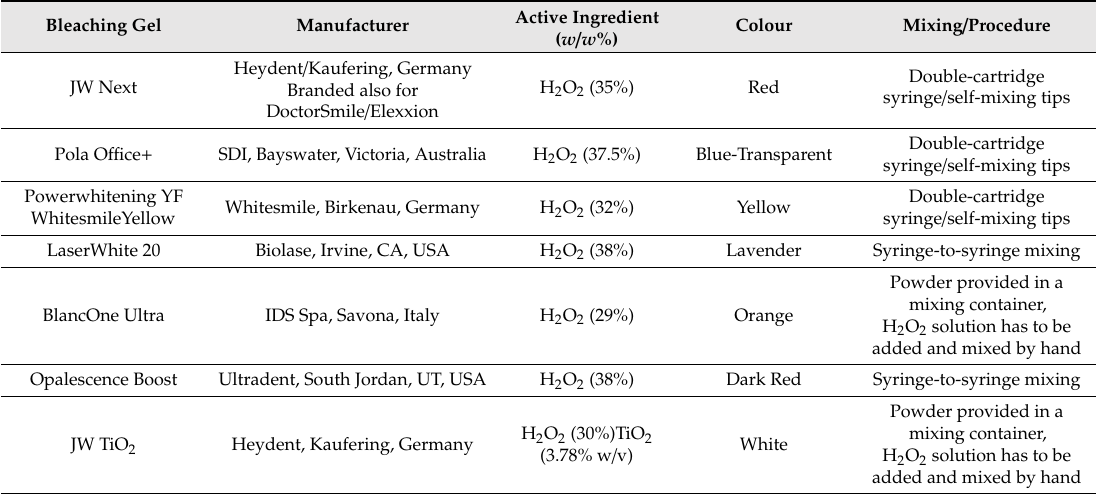
Table 1. Bleaching gels investigated and their corresponding active ingredients, contents, mixing procedure and